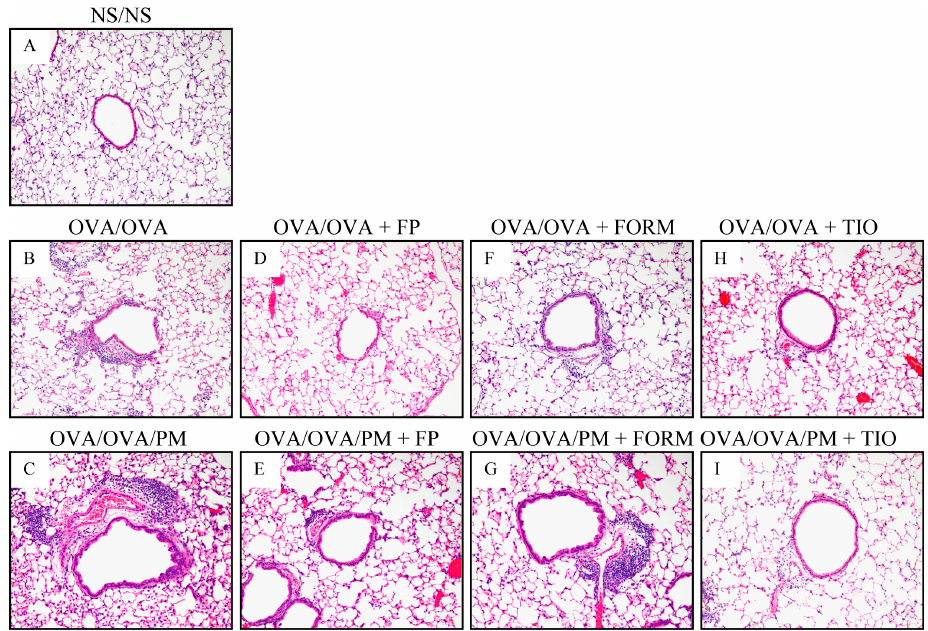
Figure 4. Effects of treatment of tiotropium bromide on histopathological changes in the lungs. Light photomicrographs of representative lung sections were stained using hematoxylin and eosin (magnification: × 200). Representative light photomicrographs of NS/NS mice ( A ); OVA/OVA mice ( B ); OVA/OVA/PM mice ( C ); OVA/OVA+FP mice ( D ); OVA/OVA/PM+FP mice ( E ); OVA/OVA+FORM ( F ); OVA/OVA/PM+FORM mice ( G ); OVA/OVA+TIO mice ( H ); and OVA/OVA/PM+TIO mice ( I ).